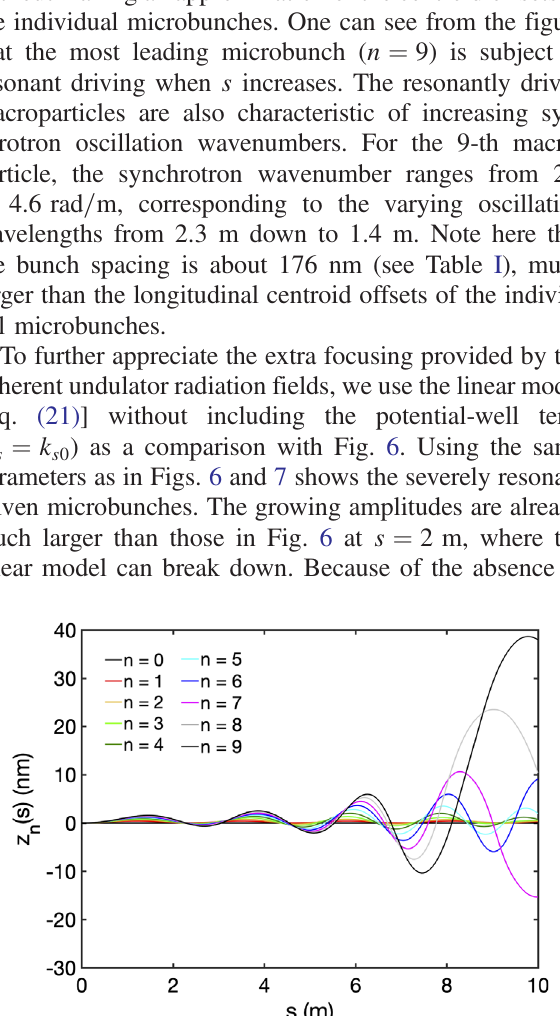
Figure 6 is obtained by numerically solving Eq. (17)